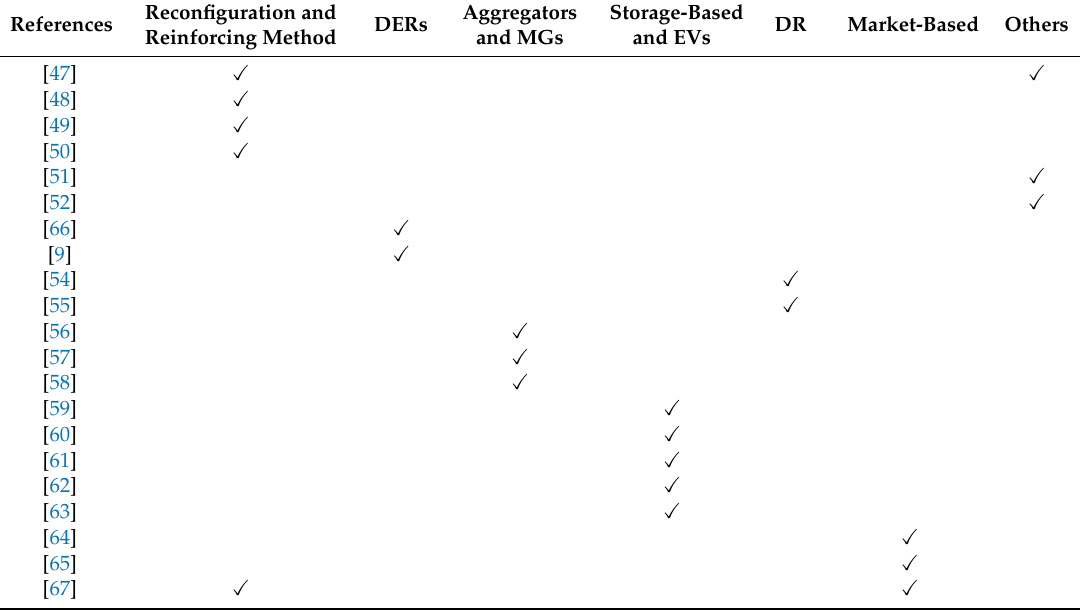
Table 1. Potential flexible resources at distribution networks (distribution system operator (DSO)